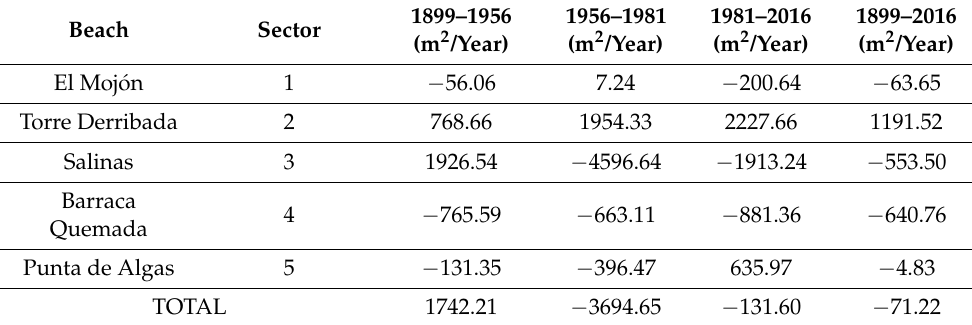
Table 1. Inter-annual variations of the surface by beach and period.